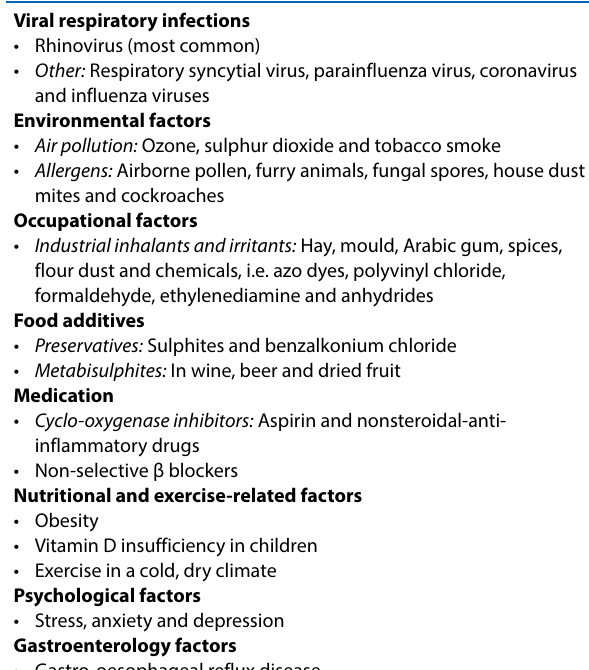
Table I: Precipitating asthma factors